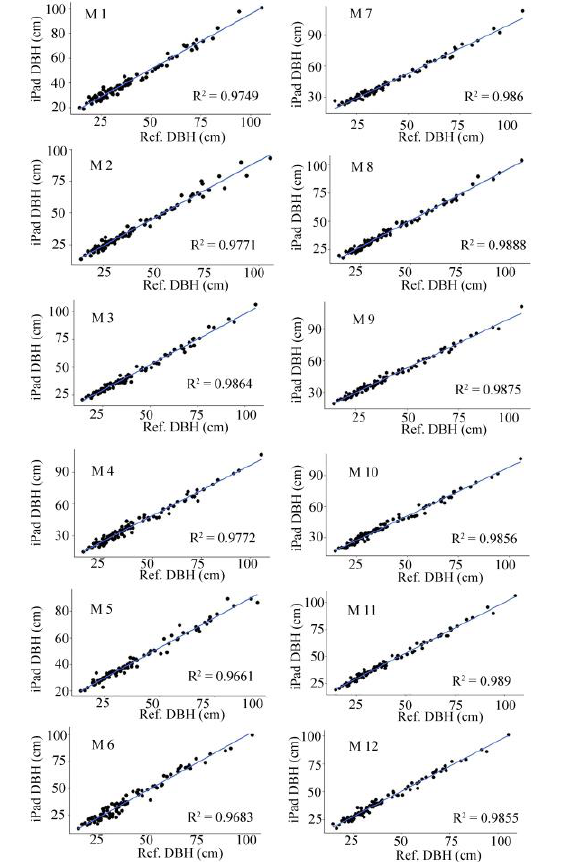
Figure 4. Scatterplot and linear regression line depicting the ideal relationship between the DBH estimated from iPad Pro data and reference data. M is an abbreviation of Method.